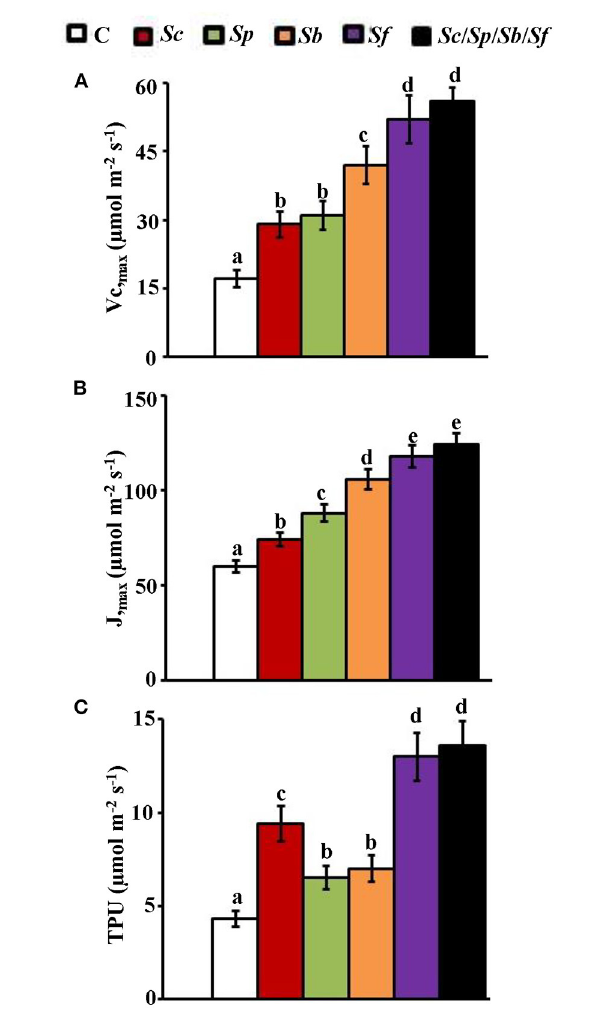
FIGURE 5 | Estimation of photosynthetic parameters in mangroves after sediment inoculation with PGPA isolates . In planta contents of (A) Vc max ; (B) J max ; and (C) TPU in mangrove shoot tissues after treatment with control, Sc , Sp , Sb , Sf , and Sc / Sp / Sb / Sf . Mangrove seedlings were grown in an evaporative-cooled greenhouse (28 ± 2 ◦ C). The values for each sampling are the means of six replicates from two independent experiments. Mean values followed by different letters are significantly ( p < 0.05) different from each other according to Fisher’s Protected LSD Test. Bars represent SE. Vc max , J max , and TPU were measured at 9 months post planting the propagules of mangrove.